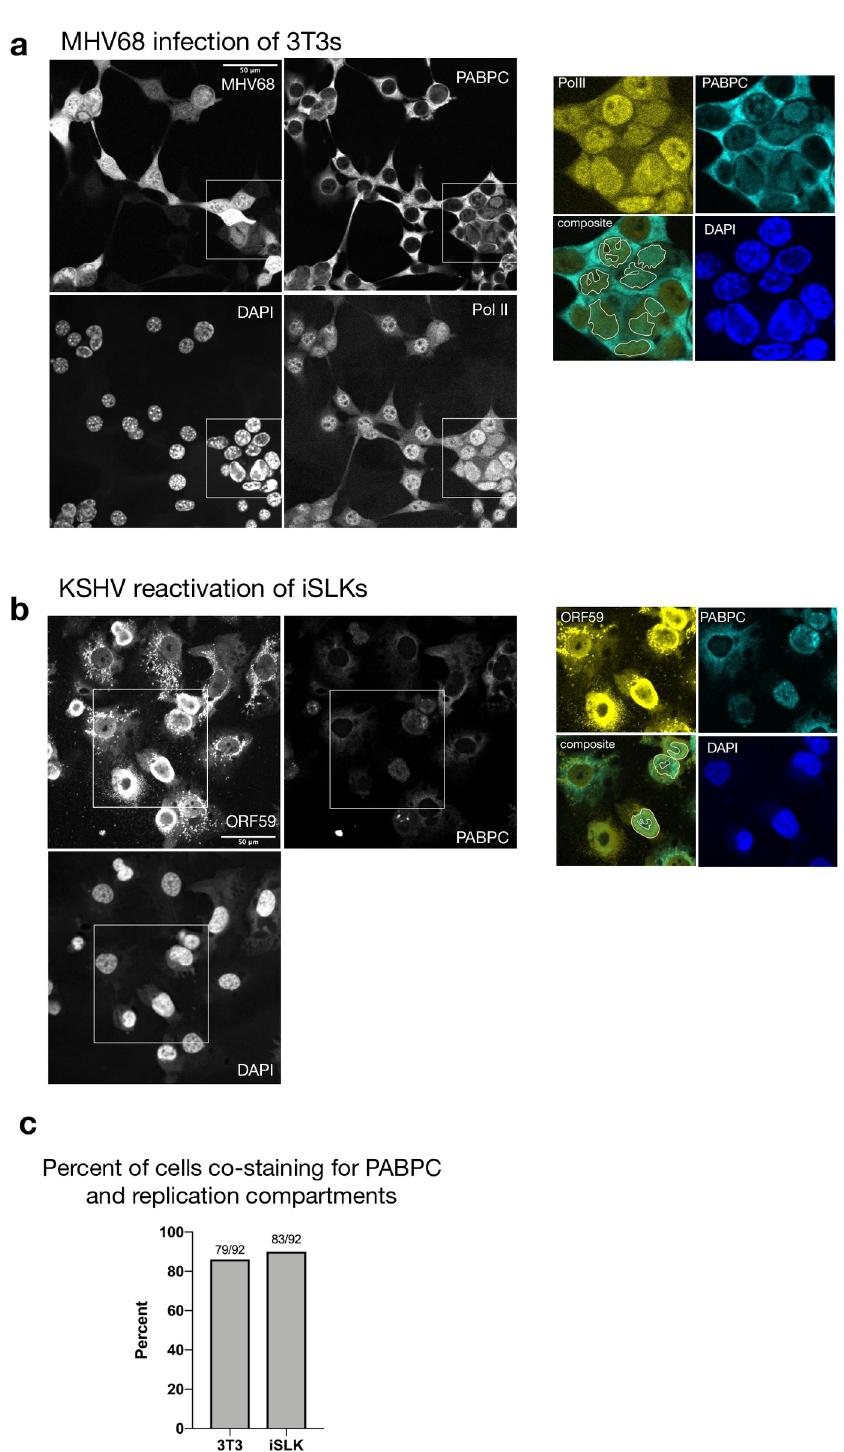
Fig 5. PABPC is not excluded from replication compartments. (A) MHV68 infected 3T3 cells were subjected to imunofluoresence (IF) analysis at 27 hpi using antibodies against PABPC and Pol II, and stained with DAPI. The MHV68 genome contains GFP, which served as a marker of infection. Cells with RCs are outlined in white. RCs were identified in cell nuclei as regions that contained Pol II but stained poorly for DAPI. The inset shows a merge of Pol II and PABPC staining for several cells that co-stain for both proteins in RCs. (B) IF was performed on KSHV-positive iSLK cells reactivated for 48 h and stained with antibodies against PABPC, ORF59 and DAPI. Cells with RCs